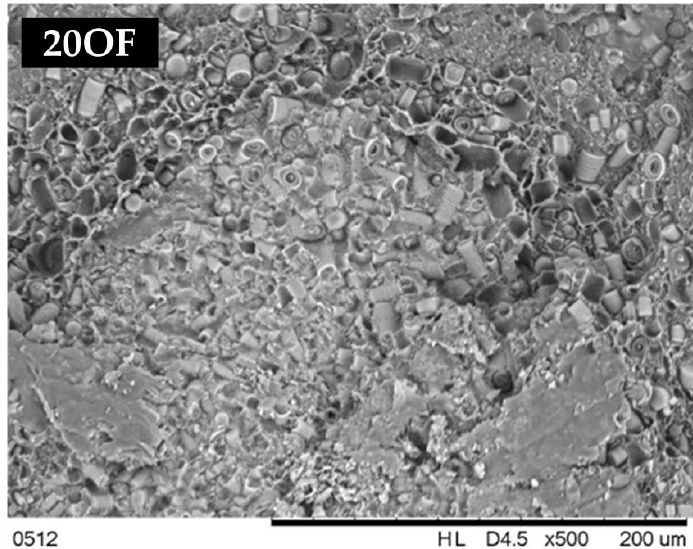
Figure 23. Relative hiding power.